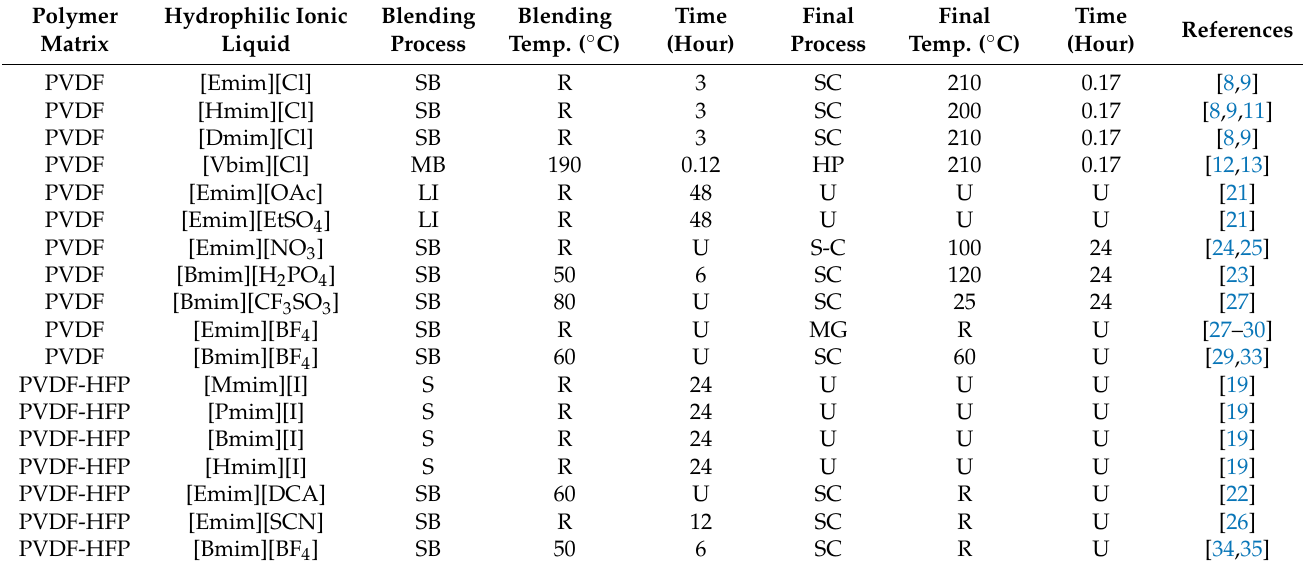
Table 4. Types of polymer matrices, hydrophilic imidazolium-based ionic liquids, and preparation processes of PVDF and PVDF-HFP